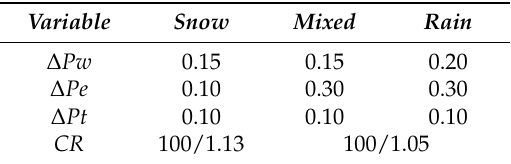
Table 3. Values for ∆ Pw , ∆ Pe , ∆ Pt and CR used for calculations. Variable Snow Mixed Rain ∆